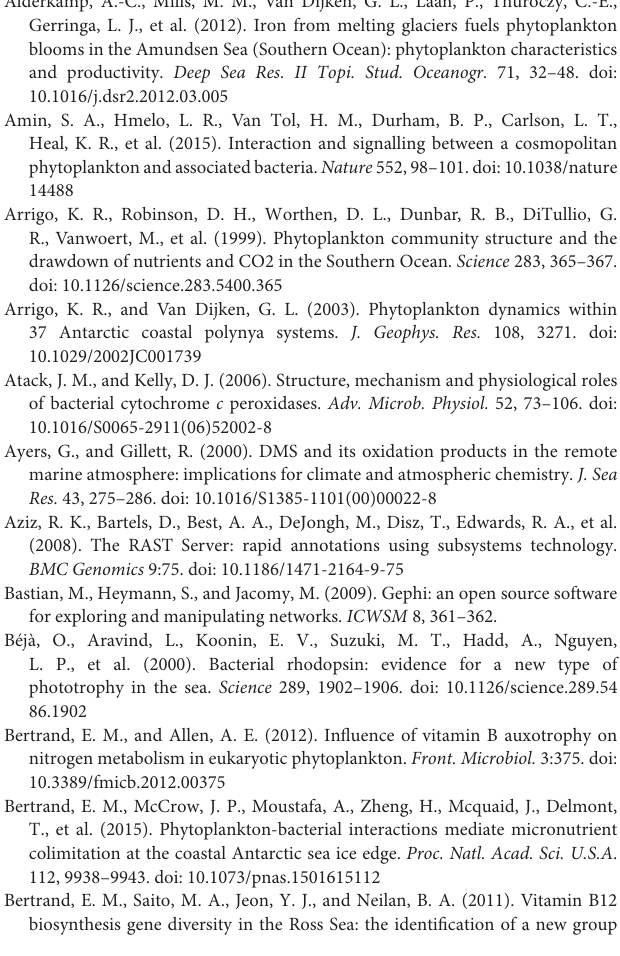
performed ( R 2 > 0.997). A total of 437 scaffolds smaller than 6kb (representing 1.3 Mb) are estimated to be missing from the draft genome. Note that the completion score of 93.8% is only based on this scaffolds length regression curve. Figure S8 | Network connecting the Micromonas ASP10-1a draft genomes recovered from the Amundsen polynya plus four Chlorophyta genomes and their annotated functions from RAST (Aziz et al., 2008) (a total of 3.086 functions). The network was performed using Gephi (Bastian et al., 2009) and Force Atlas 2. Dataset S1 | Statistical analyses ( t -test and equal variance, p -value cut-off of 0.05) of functions detected in the six bacterial draft genomes ( n = 4253 ) in order to discriminate functions differentially present between (I) taxa (Bacteroidetes vs. Proteobacteria) and (II) life styles [free-living taxa (Rhodobacteraceae; Polaribacter; Flavobacteriaceae) and particle-associated taxa (Oceanospirillaceae; SAR92; Cryomorphaceae)]. Dataset S2 | Summary of online blastx against nr (NCBI database) for 86 genes of particular interest in the study. RAST ORFs can be found in the Genbank files. Note that only the first best hit matching the RAST functional annotation is summarized. All e -values were below e-10. Dataset S3 | Metadata summary for the Global Ocean Survey stations utilized in Figure